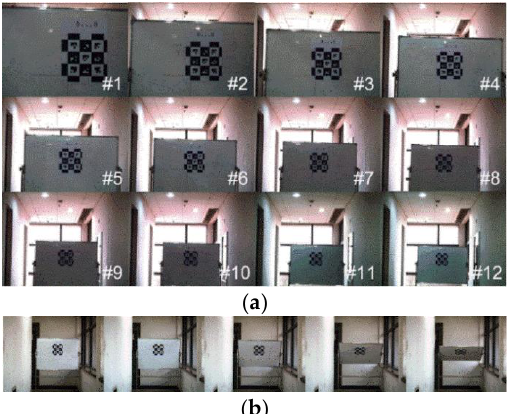
Figure 7. Orientation accuracy experiments with different configurations. ( a ) Different depth. ( b )